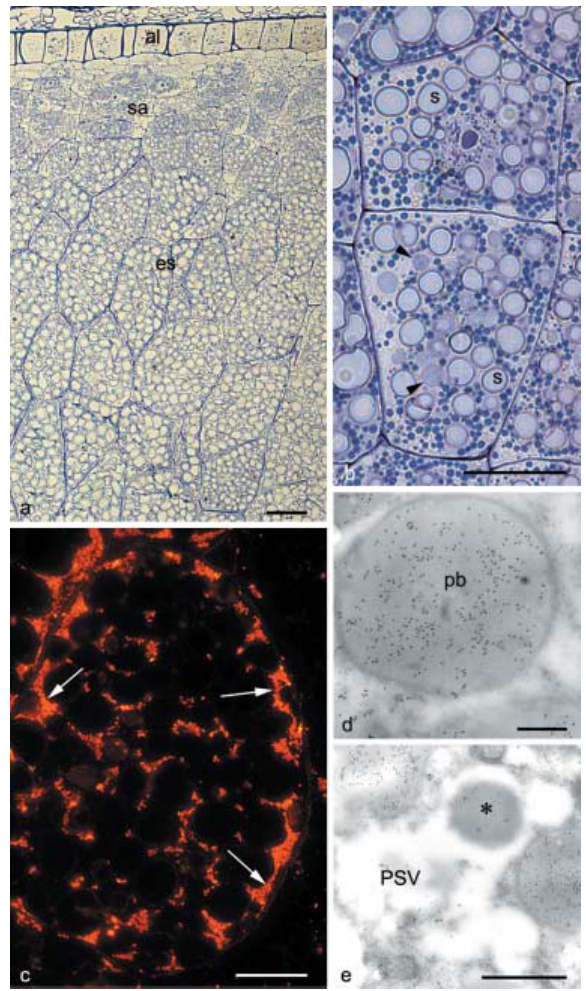
Figure 5 Localization of Zm 2G12 SEKDEL . (a, b) Spurr sections. Light microscopy, toluidine blue. Note the aleurone (al), the young cells in the subaleurone (sa) and the larger cells in the endosperm (es), packed with starch. In the enlargement in (b), the small, spherical zein bodies, stained in blue, can be identified easily. Note also the presence of protein storage vacuoles (PSVs), stained in lighter blue (arrowhead) and similar in size to the starch grains (s). (c) LRWhite section. Fluorescence microscopy, localization of κ -chain. See the strong labelling on the zein bodies (arrows). No significant labelling can be observed in other cell compartments. (d, e) LRWhite section. Electron microscopy, localization of κ -chain. Abundant gold probes restricted to the α -zein portion of the protein bodies (pb). No significant labelling can be found within the PSV. Globulin inclusion (*). Scale bars: (a) 50 μ m; (b, c) 20 μ m; (d, e) 0.25 μ m.